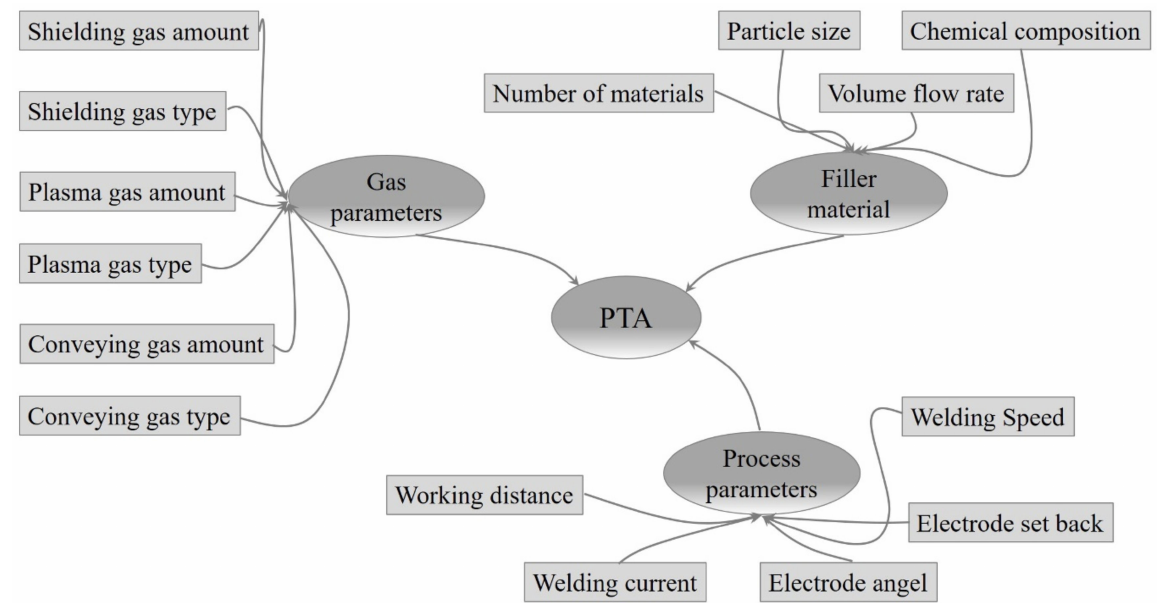
Figure 2. Setting parameters of the PTA